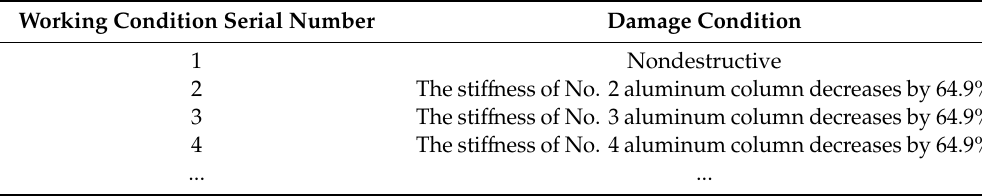
Table 1. Physical experiment condition of the frame structure.